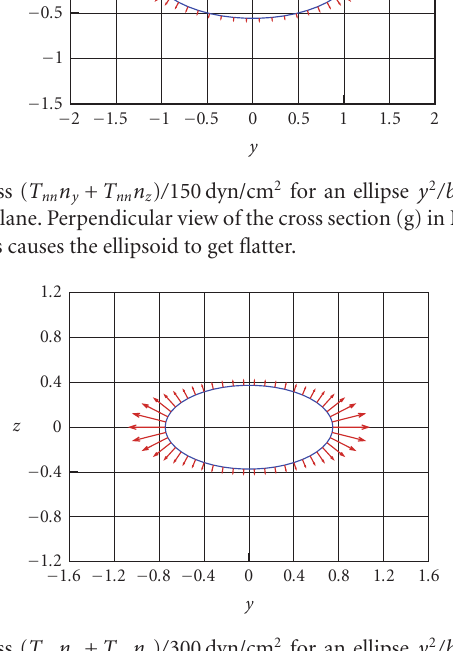
Figure 6.9. Normal stress ( T nn n y + T nn n z ) / 300dyn/cm 2 for an ellipse y 2 /b 2 + z 2 /c 2 = 1 − 2 . 6 2 /a 2 at x = 2 . 6 cm in the ( y , z )-plane. Perpendicular view of the cross section (h) in Figure 6.1. Strong tension at the right and left poles causes the ellipsoid to get flatter.